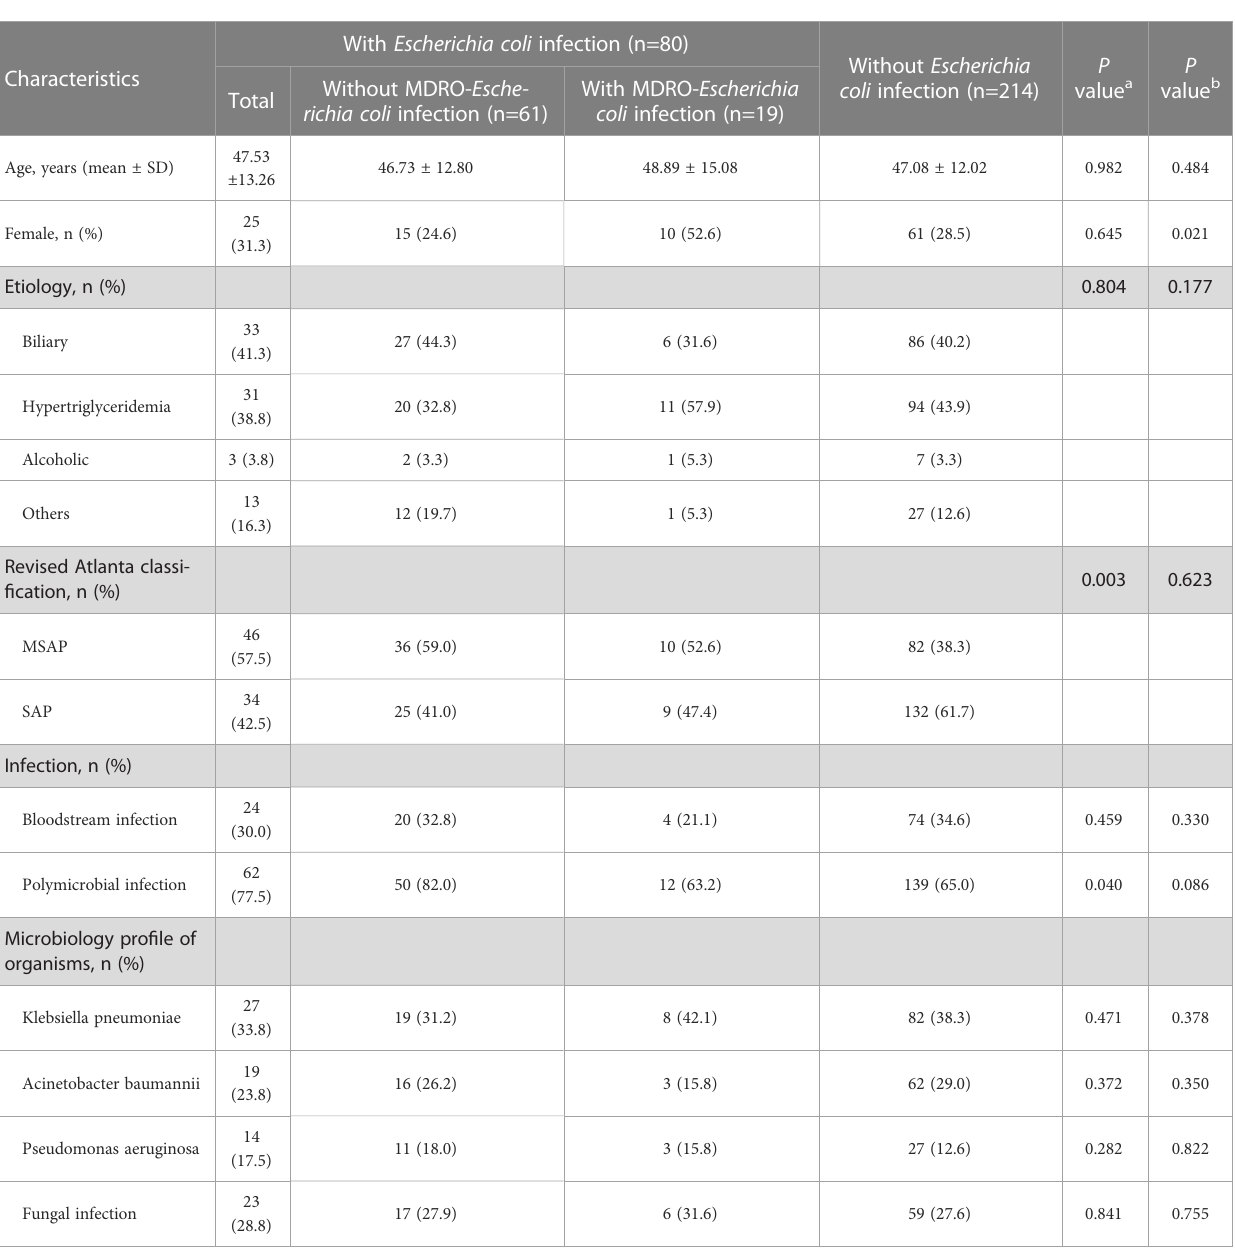
TABLE 1 Comparison of baseline and clinical characteristics among the four groups.